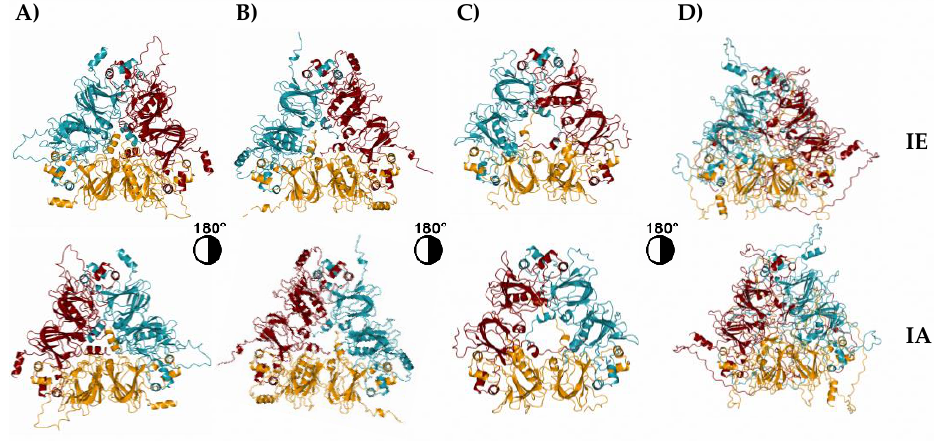
Figure 4. Structural models generated from Ah11Sn paralogs. ( A ) Ah11SA (PDB ID 3QAC); ( B ) Ah11SB; ( C ) Ah11SC; ( D ) Ah11SHMW. IA: intrachain disulfide bond face; IE: interchain disulfide bond face.